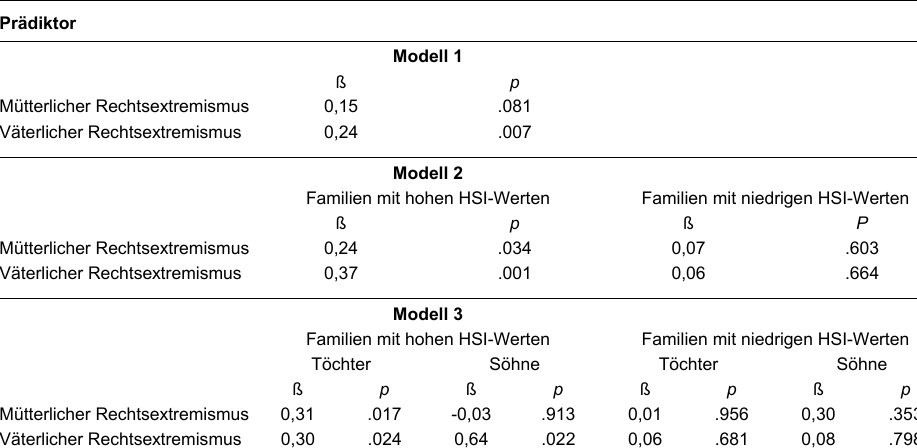
Tabelle 2 : Prädiktion von Rechtsextremismus, differenziert nach familialem HSI-Level und Geschlecht